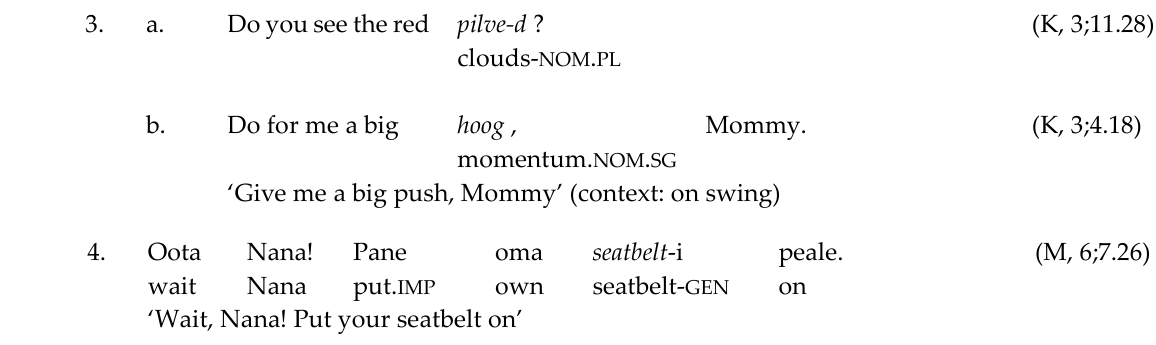
as noted by Myers-Scotton and Jake (2017) and Toribio